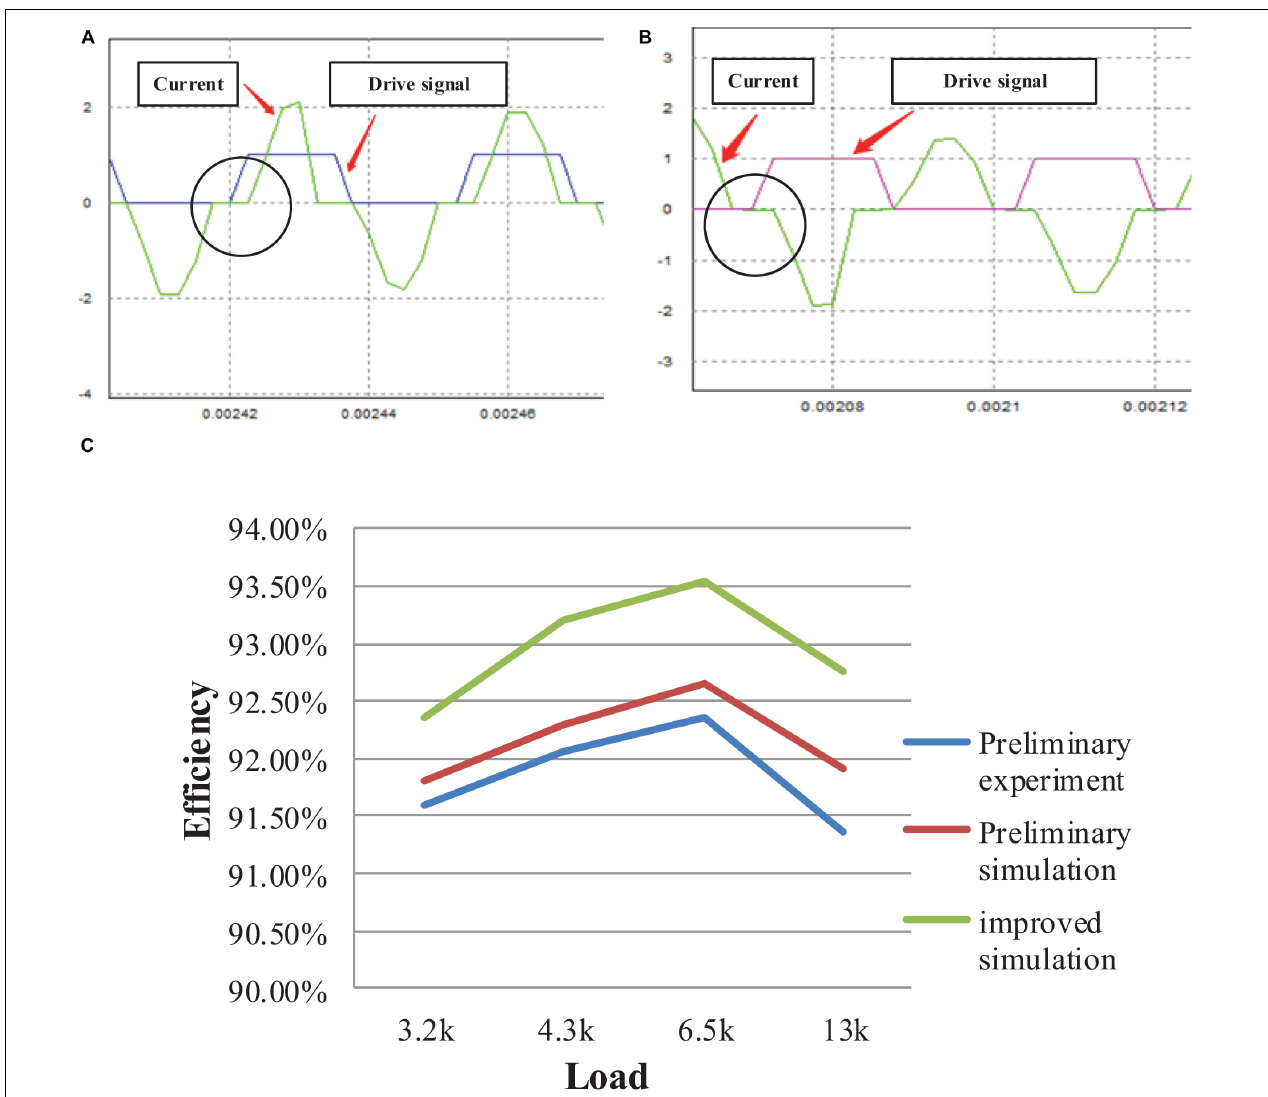
FIGURE 13 | Efficiency comparison. (A) Simulation Q 2 . (B) Simulation Q 3 . (C) Efficiency